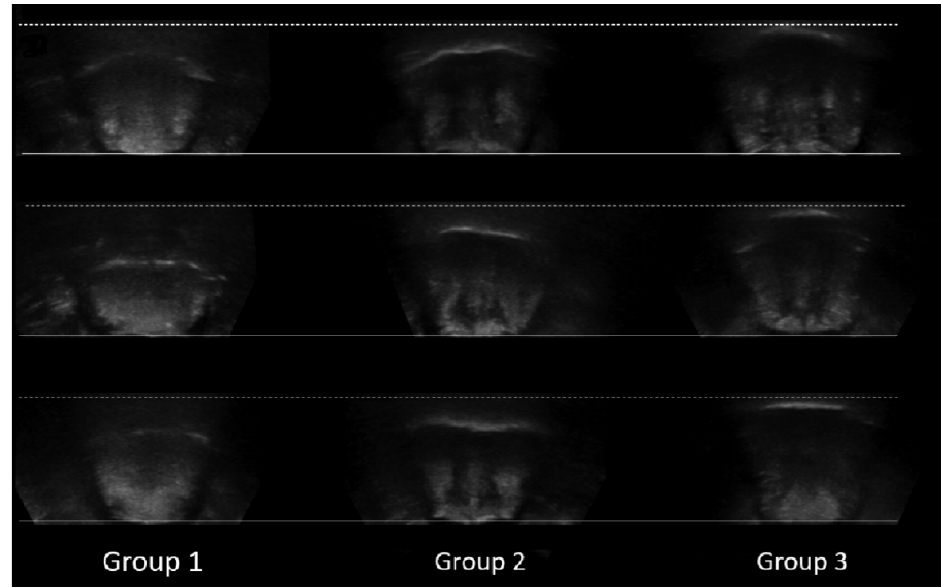
Figure 5. Comparison of illustrative ultrasound images in each group. The solid and dashed lines represent the lowest and the highest parts of the tongue (dorsal surface of the tongue) in Group 3, respectively.